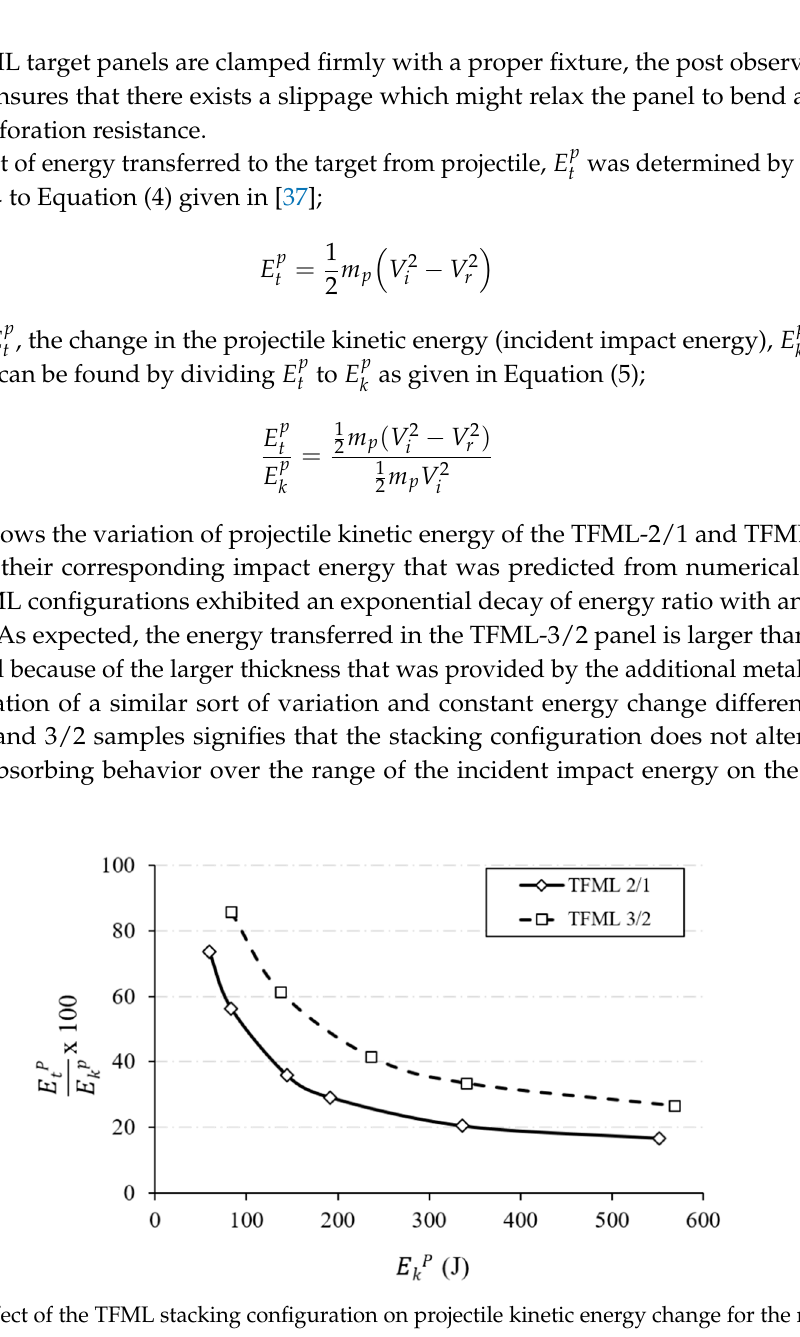
Figure 3. Variation of the projectile residual velocity for different impact velocity. ( a ) TFML-2/1 panel; ( b ) TFML-3/2.